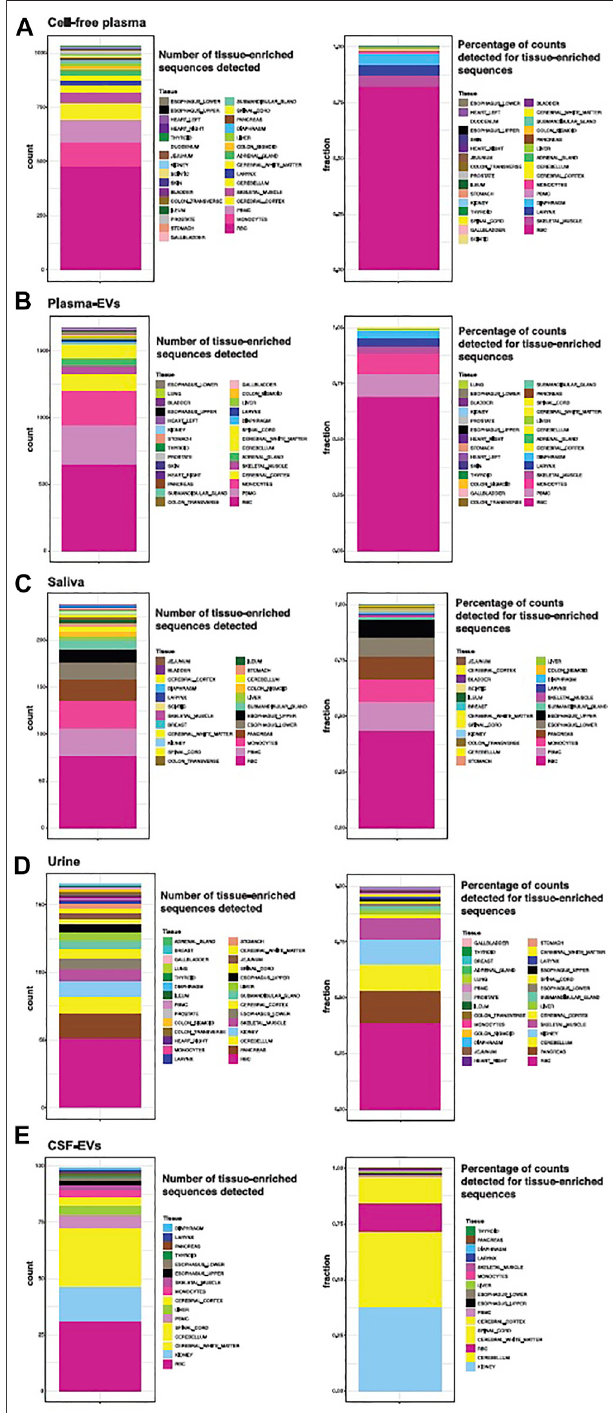
FIGURE 8 | Tissue-elevated miRNA/isomiR Sequence Detection in Bio fl uids. The number of tissue-elevated sequences that were detected in each bio fl uid and their abundance are displayed in Panel. The number of tissue-elevated sequences detected for each tissue in cell-free plasma are shown in the fi rst stacked bar plot Panel (A) . Tissue-elevated sequences from31differenttissueandcelltypesweredetected(thenumbersarefoundin